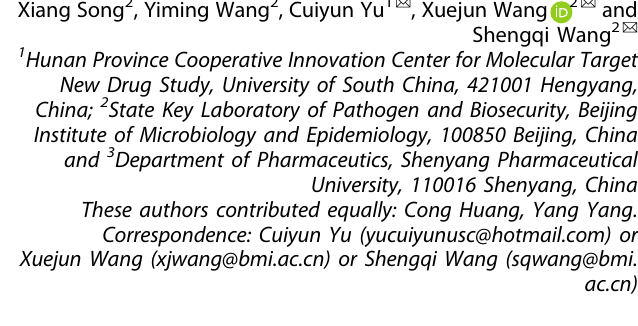
Fig. 1 Design and application of the three-functional cell-fusion reporting system. a Four different recombining proteins comprising split mNeonGreen and split NanoLuc were fused with different ends of bJun or bFos. NG and CG represent the N- and C-terminal fragments of mNeonGreen, respectively. SmBiT and LgBiT represent the small and large fragments of NanoLuc, respectively. b The luciferase activities of these four different recombining proteins were detected after transfecting or co-transfecting their plasmids into HEK293T cells for 36 h. Mock indicated that conditions were consistent, except that no plasmid was transfected. c Schematic of this three-functional reporting system for cell-fusion assay. HEK293T cells expressing CGFL and spike were co-cultured with cells expressing NGJS, ACE2, and tdTomato to trigger cell fusion. The green fl uorescence signal and luciferase activity were restored and located in the nucleus. d The luciferase activities of cell-fusion mediated by the spike D614G variant were measured at the indicated time point post cell co-culture, and plasmids without spike expression served as the negative control (non-spike). e The fl uorescence signals of the spike D614G mediated cell fusion were observed at 10 h post cell co-culture by using a microscope. Green fl uorescence represents recombinant mNeonGreen, and red fl uorescence represents cells